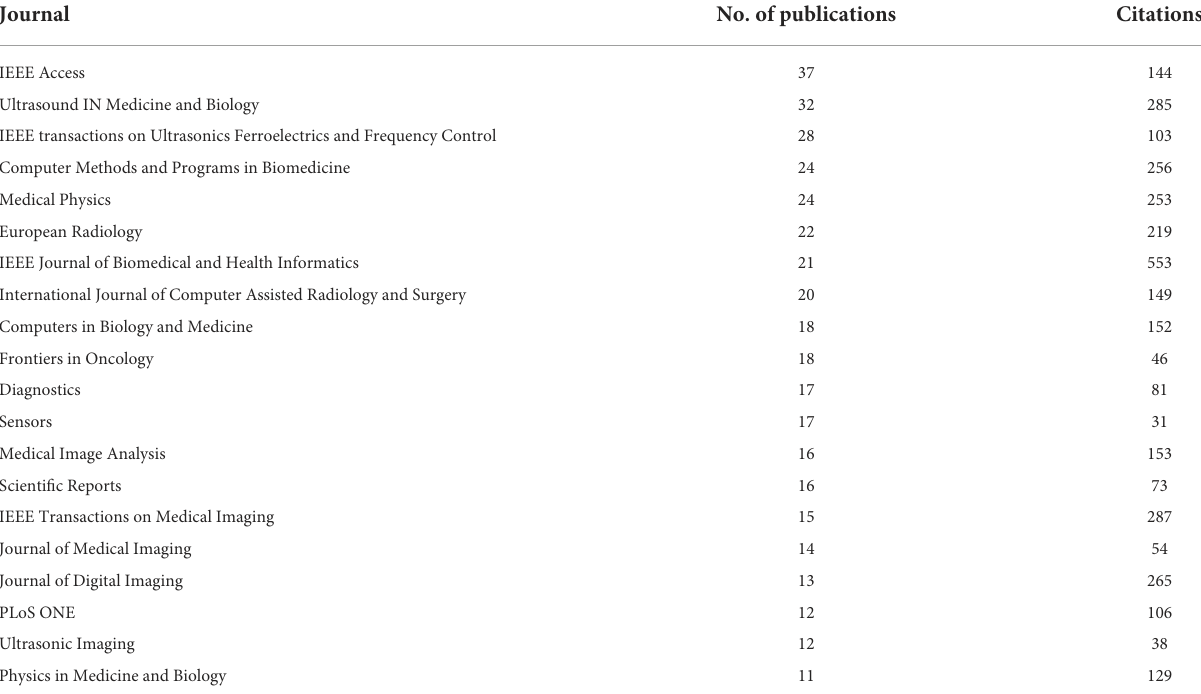
TABLE 3 Top 20 journals with most numbers of publications related to the use of AI in